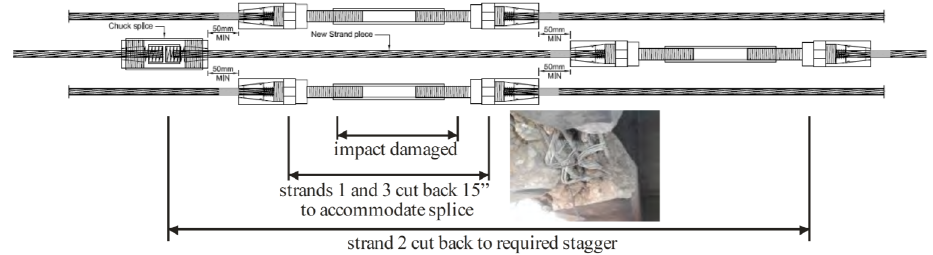
Figure 10. Staggering of the strand splices [15].